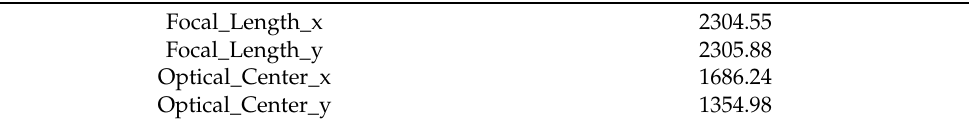
Figure 2. Training and testing data example. Table 1. Camera characteristics for ApolloCar3D dataset.